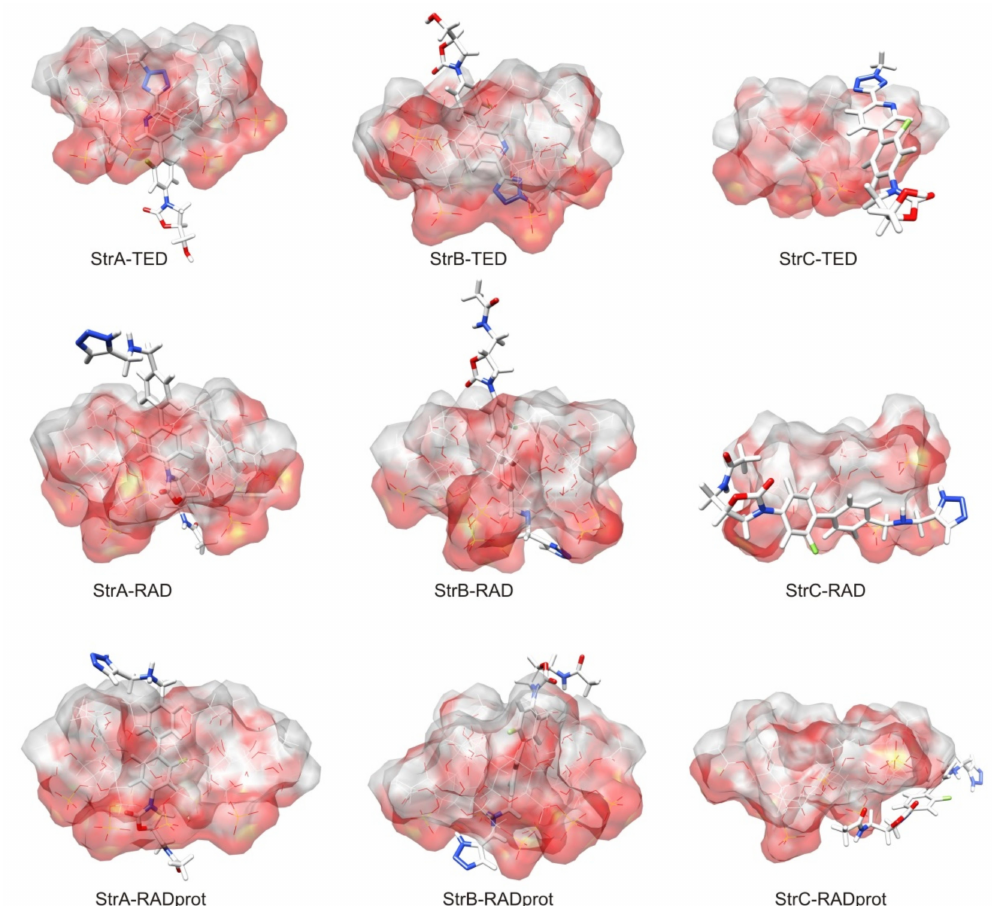
Figure 3. Representative conformations from the most probable cluster based on RMSD of the TED and RAD complexes with HDAS- β